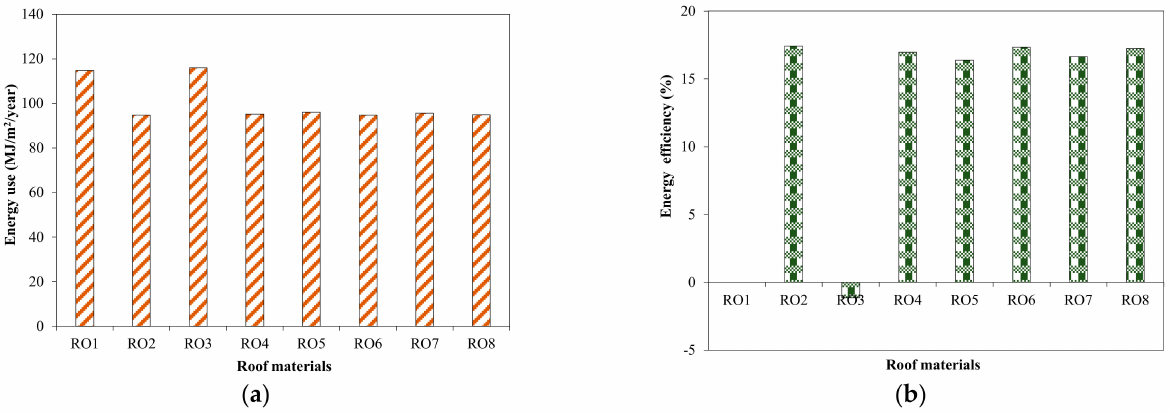
Figure 12. Effect of roof materials on energy use in tested house building. ( a ) Energy use; ( b ) Efficiency.